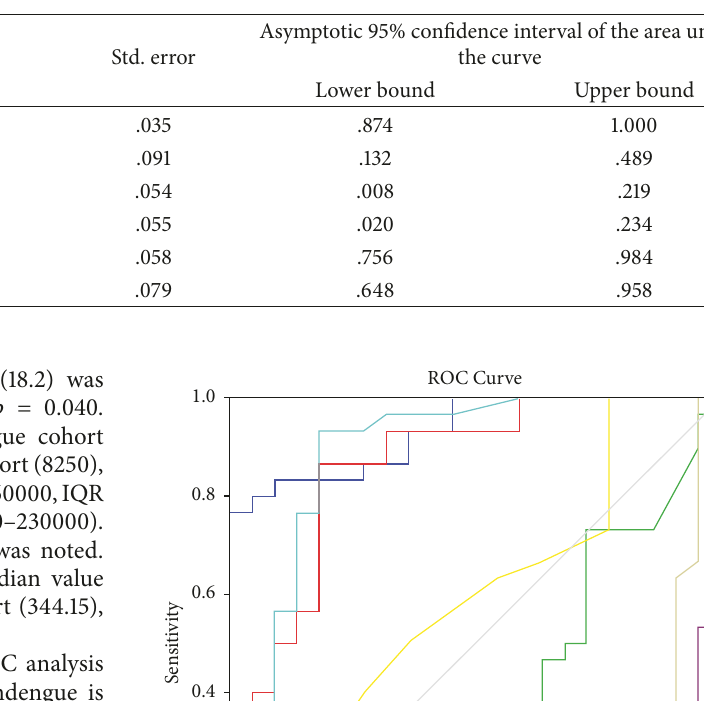
Table 2: Area under the curve for different parameters by receiver operating characteristic curve.